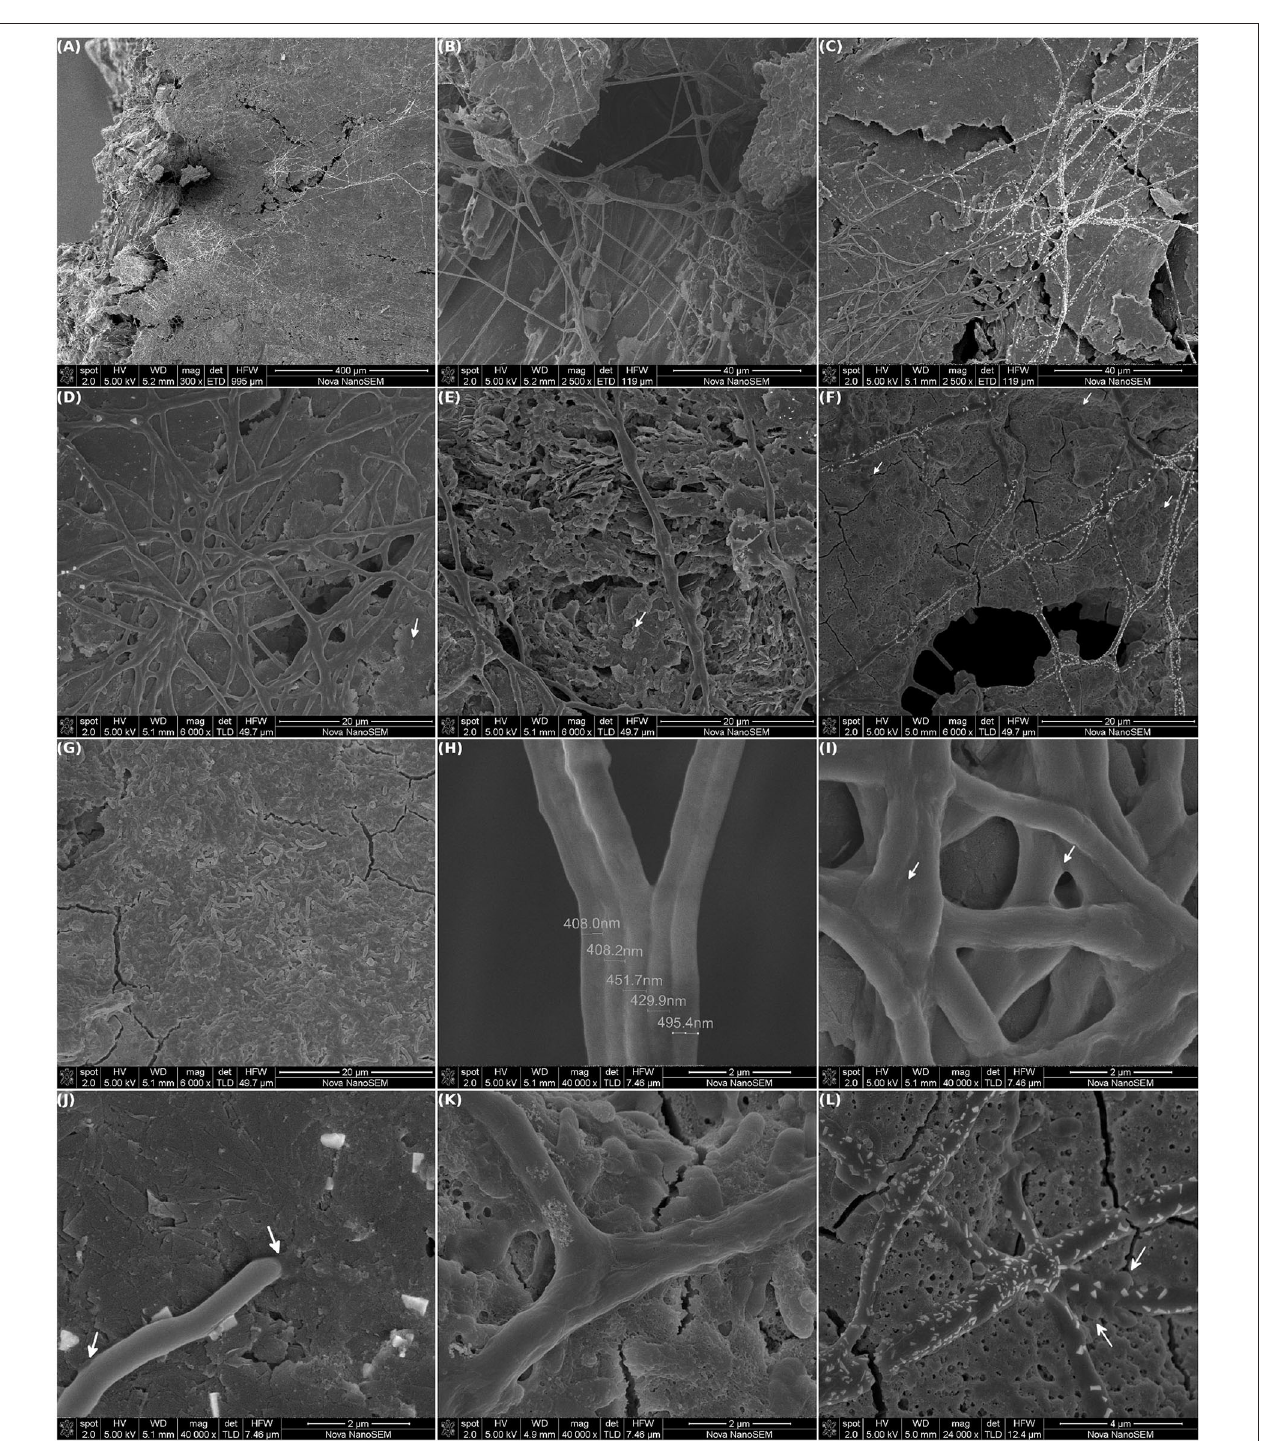
FIGURE 4 | Scanning electron microscopy of MEC-a working electrode (WE). The MEC was inoculated with the Fe-reducing microorganisms enriched from the river sediment and the WE (graphite) was initially polarized at +240 mV vs. Ag/AgCl. The MEC was operated at 30 ◦ C in anaerobiosis, other operational parameters were modified as specified in Figure 2 . At the end of the experiment (41 days) the WE was removed and observed by SEM: (A–C) Intertwined millimeter long cables of bacteria running along the WE surface. (D–G) Differences in the biofilm structure were observed over the electrode: zones of high density of cables and low density of isolated cells ( D , white arrow), zones with low density of cables and higher density of aggregated cells (E) and biofilm matrix ( F , white arrows) and (G) zones with no cables. (H) Single cables width. (I) Fusion of several cables. (J) Points of intimate contact with the electrode surface, white arrows. (K,L) The cables extended in many directions and have blebs (white